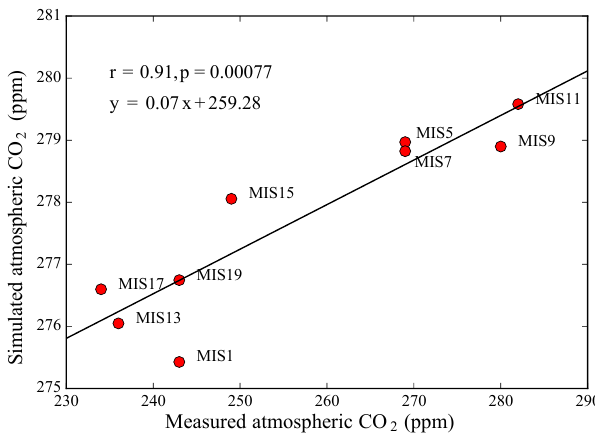
Figure 6. Simulated CO 2 in the interglacial simulations of the OC series as a function of the measured CO 2 from data (Lüthi et al., 2008). The Pearson correlation coefficient and the p value are indi- cated at the